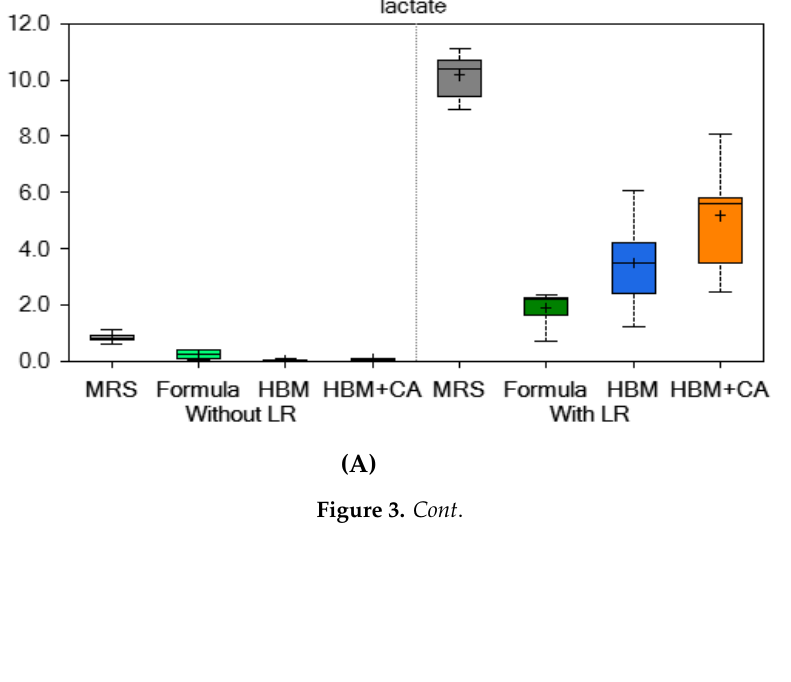
Table 1. Elevated amino acids involved in anti-inflammation function and succinate (part of glyoxylate cycle to generate ATP) in HBM + LR group as compared to formula + LR